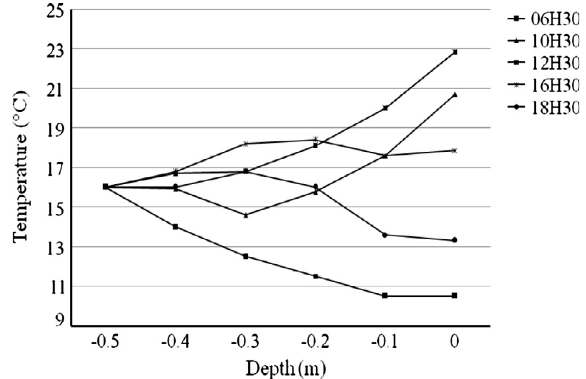
Figure 12. Water content evolution in terms of depth (May 15).